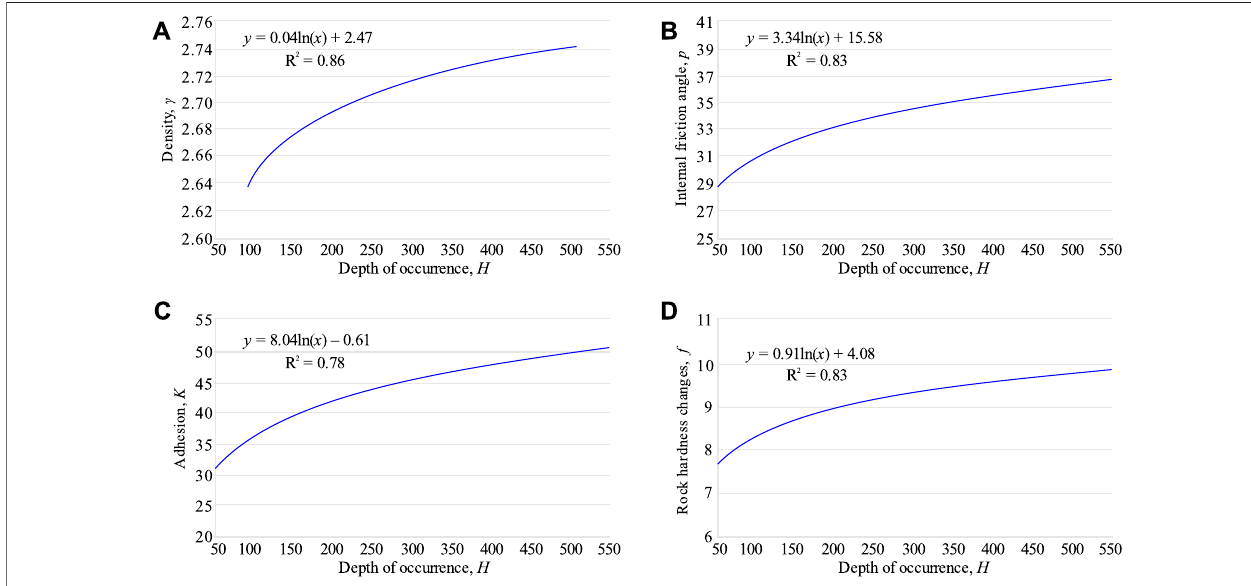
FIGURE 5 | Dependence of the massive limestone strength properties with the depth of its occurrence (H): (A) density changes, g; (B) changes in the internal friction angle, r ; (C) adhesion changes, K; (D) rock hardness changes, f.